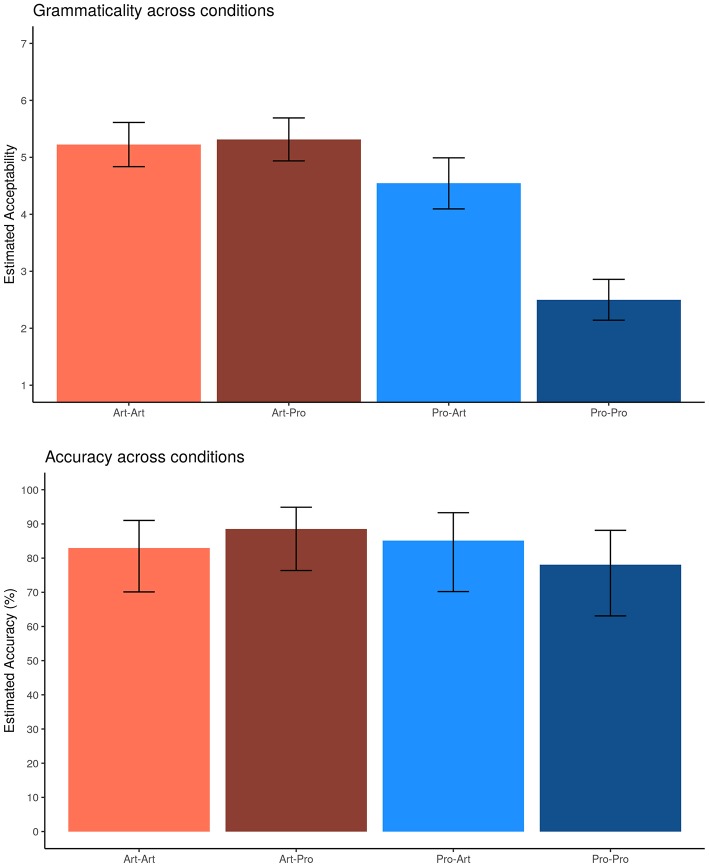
Offline results: estimated acceptability (7-point Likert scale) judgments (experiment 1) and accuracy (%) in answering comprehension questions (experiment 2). Error bars represent 95% confidence intervals around the models' estimates.